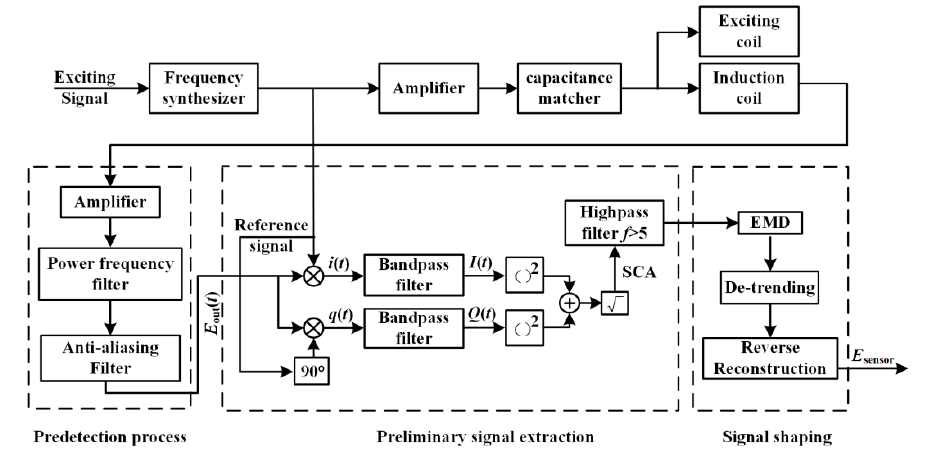
Figure 6. Block diagram of the signal measurement system.